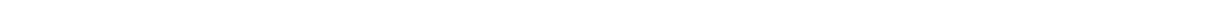
Fig. 1 Task design and behavioural performance. a Visual orientation reproduction task with preparatory auditory cues and visual distractors. Participants reproduced the orientation of the visual target grating using a computer mouse. In half the trials, targets were preceded by an auditory warning cue. Targets could be followed by no distractors, or by a visual distractor at one of three ISIs (20, 100, 200 ms). Target-probe intervals and inter-trial intervals were drawn independently of cue and distractor presence. b Average orientation reproduction errors (in degrees) and reaction times (in ms) for cued and uncued trials, as well as their difference, as a function of distractor presence and ISI. c Mixture-modelling parameters as a function of cue and distractor presence. 'c + ' for cue present, 'd − ' for distractor absent, and so on. d Response distributions centred on the target and the distractor orientation. To ensure suf fi cient trial numbers, we only considered distractor-present trials in the 100-ms ISI condition in panels c and d . Error bars represent ±1 s.e.m. calculated across participants ( n = 30). ISI, inter-stimulus-interval; SOA, stimulus-onset-asynchrony. * p < 0.05; ** p < 0.01; *** p < 0.001. Scattered data points in panels b and c show individual participant data. To increase visibility, individual data points were slightly jittered in the horizontal plane